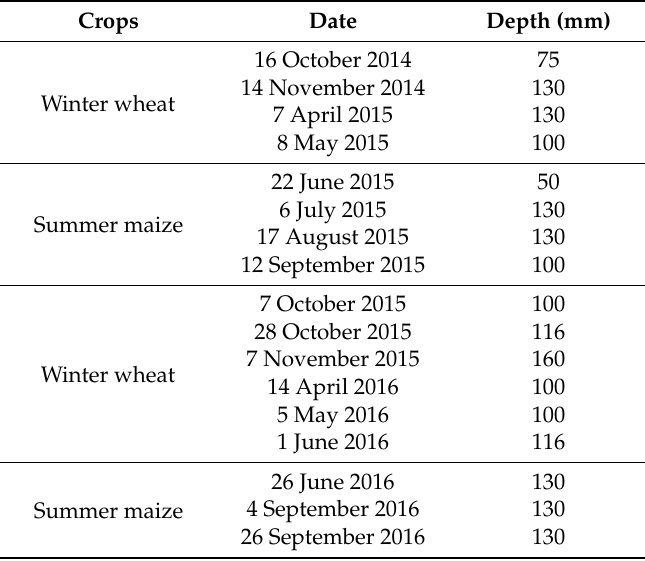
Table 1. The irrigation depth at each time